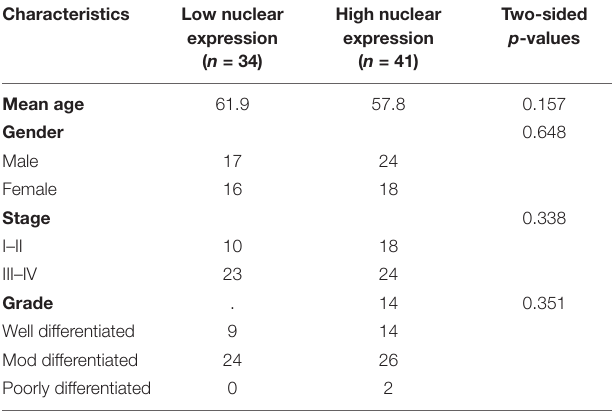
TABLE 2 | Clinicopathological characteristics according to NAP1L1 nuclear